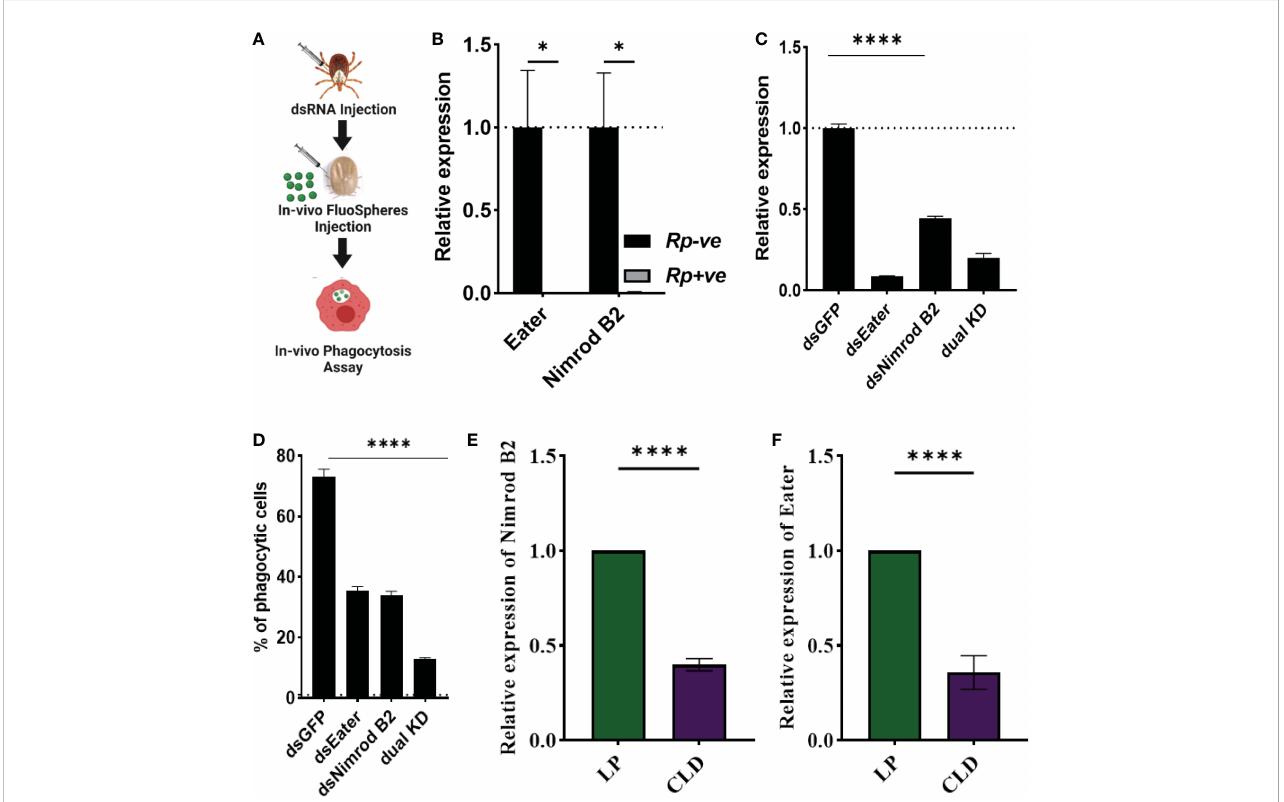
FIGURE 7 Nimrod B2 and eater homologs as functional markers of hemocyte phagocytosis. The role of nimrod B2 and eater silencing on in vivo phagocytosis was evaluated in Am. maculatum hemocytes (A) . qPCR validation of bulk RNA expression pro fi les of nimrod B2 and eater in uninfected and R. parkeri- infected Am. maculatum hemocytes (B) . dsRNA was injected into Am. maculatum female ticks to disrupt the expression of nimrod B2 and eater genes and con fi rmed by qPCR (C) . The proportion of phagocytic hemocytes was compared with dsGFP-injected ticks (D) . Additional validation of phagocyte depletion showing a signi fi cant reduction in nimrod B2 (E) and eater (F) transcript in CLD-injected ticks. Gene expression was normalized to Am. maculatum actin. Data were analyzed using unpaired t-tests in GraphPad Prism v8.4.1. *P < 0.05, ****P <